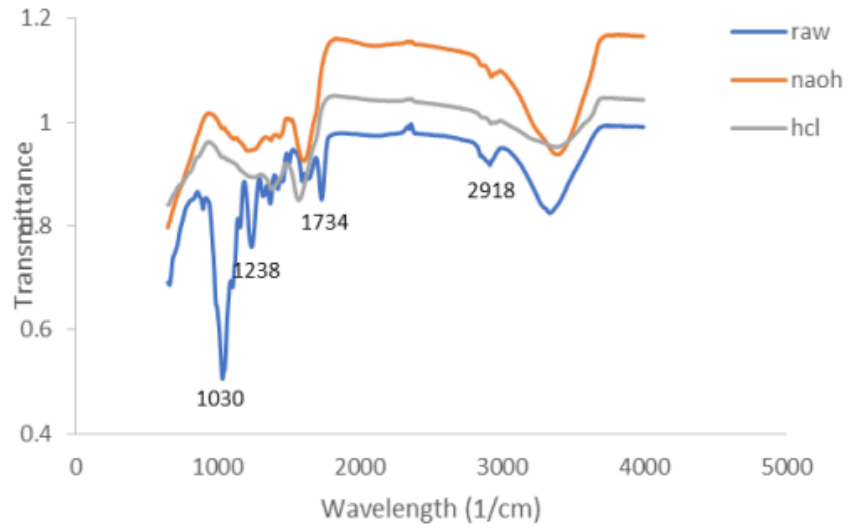
Figure 5. FTIR graph of raw, NaOH-treated, and HCl-treated KF